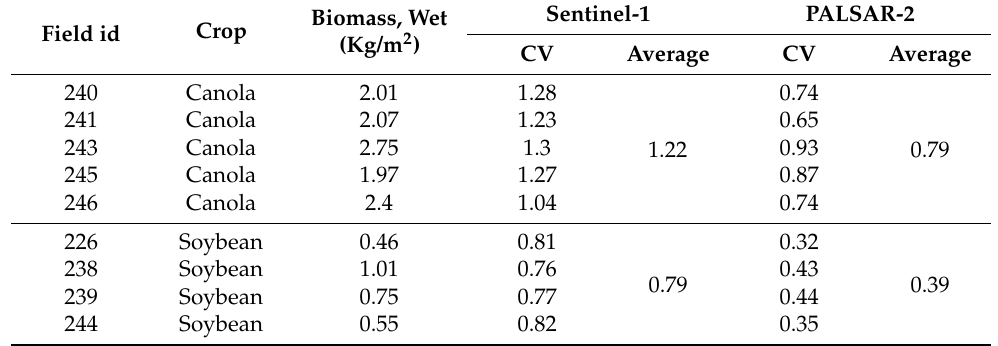
Table 6. Field data for wet biomass (time-averaged) and the coefficient of variation (time-aver- aged).